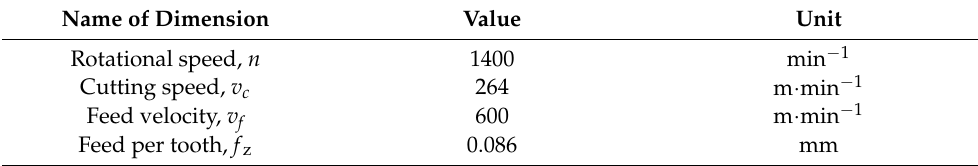
Table 3. Kinematic parameters of the face milling